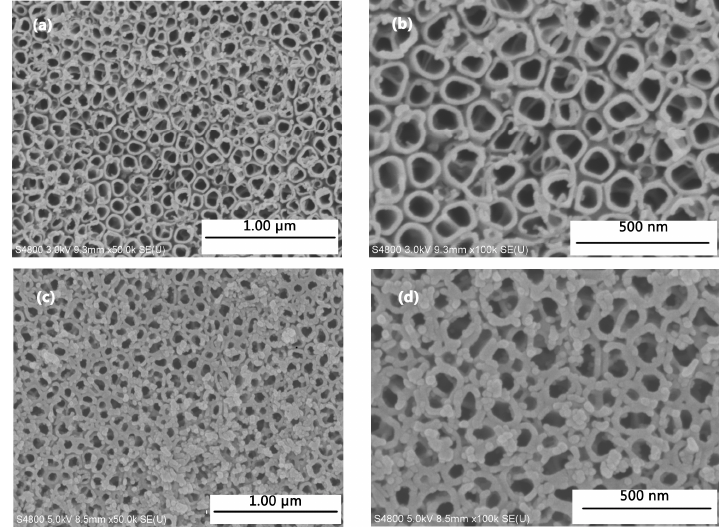
Figure 2. Scanning Electron Microscopy (SEM) micrographs of samples. Top surface view of anodized TiO 2 NTs (( a ) ×50,000; ( b ) ×100,000). Top surface view of anodized TiO 2 NTs deposited with AuNPs TiO 2 NTs (( a ) × 50,000; ( b ) × 100,000). Top surface view of anodized TiO 2 NTs deposited with AuNPs (( c ) ×50,000; ( d ) ×100,000). (( c ) × 50,000; ( d ) ×